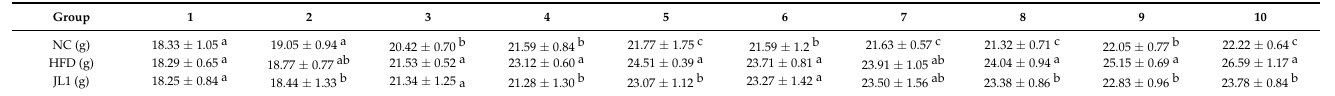
Table 3. Body Weight for Experimental Mice.